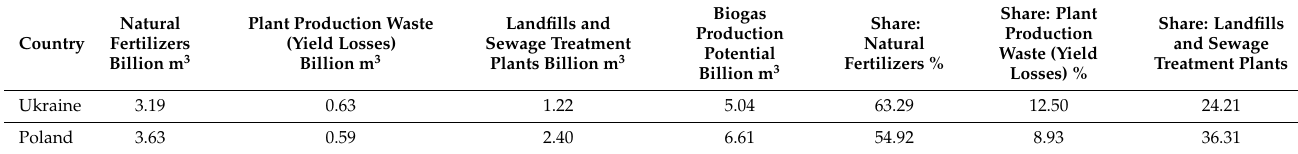
Table 2. Basic potential of biogas. Source: Own study.